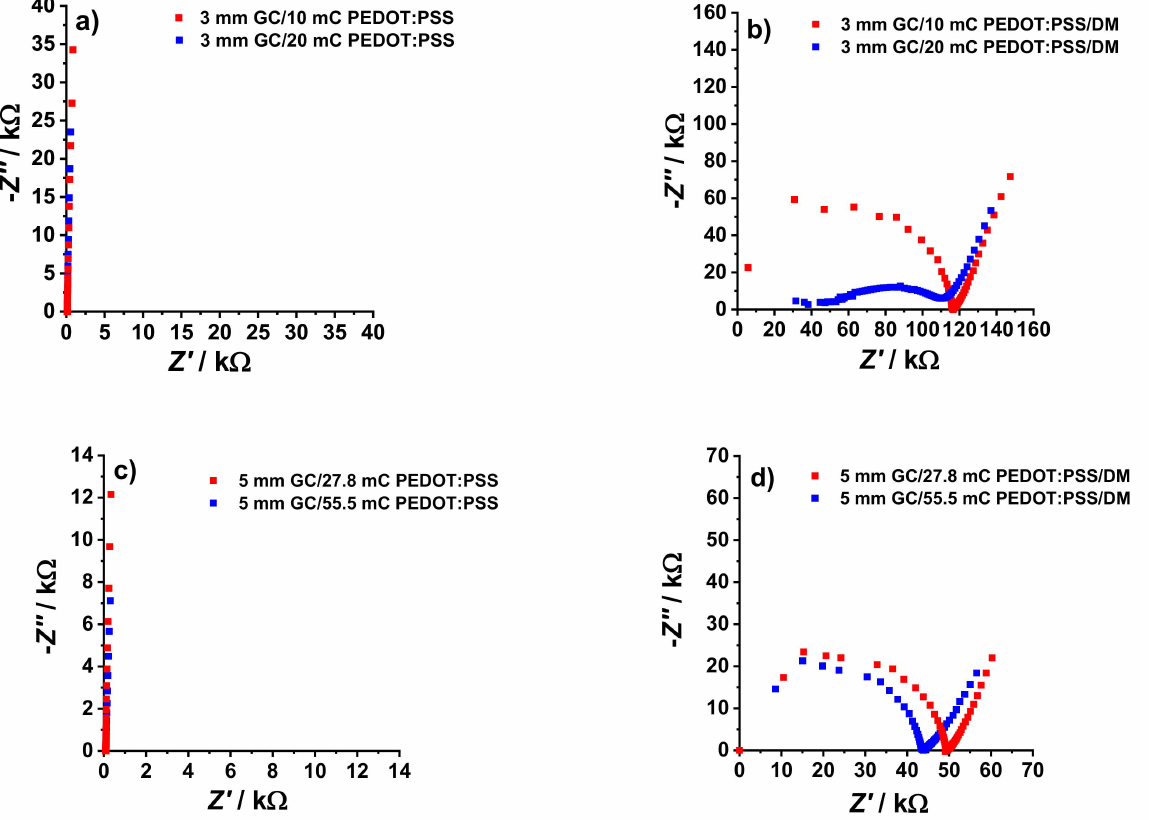
Figure 2. Electrochemical impedance spectra of GC/PEDOT:PSS electrodes with Ø GC = 3 mm ( a , b ), Ø GC = 5 mm ( c , d ), and different Q polym (as indicated in the figures) recorded in 10 − 1 M KCl at OCP in the frequency range of 100 kHz–10 mHz and excitation amplitude of 10